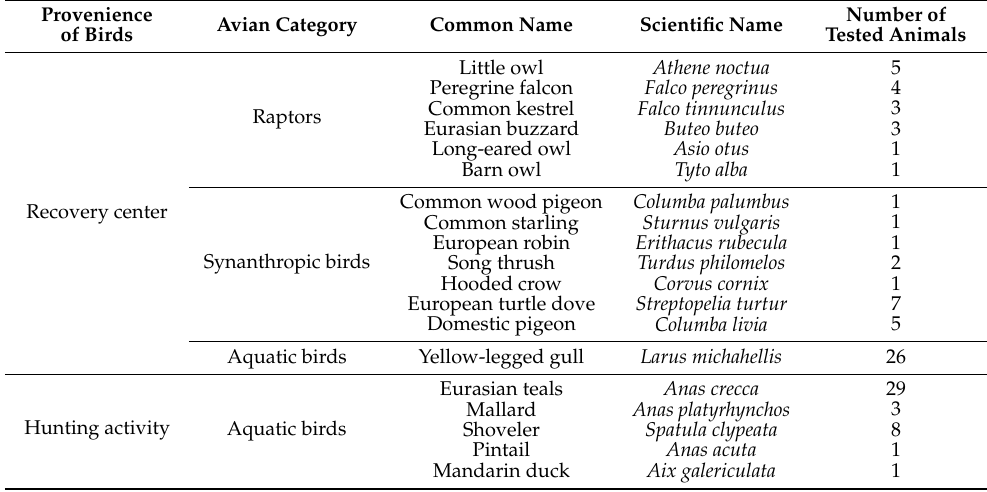
Table 4. Tested birds in relation to their provenience and